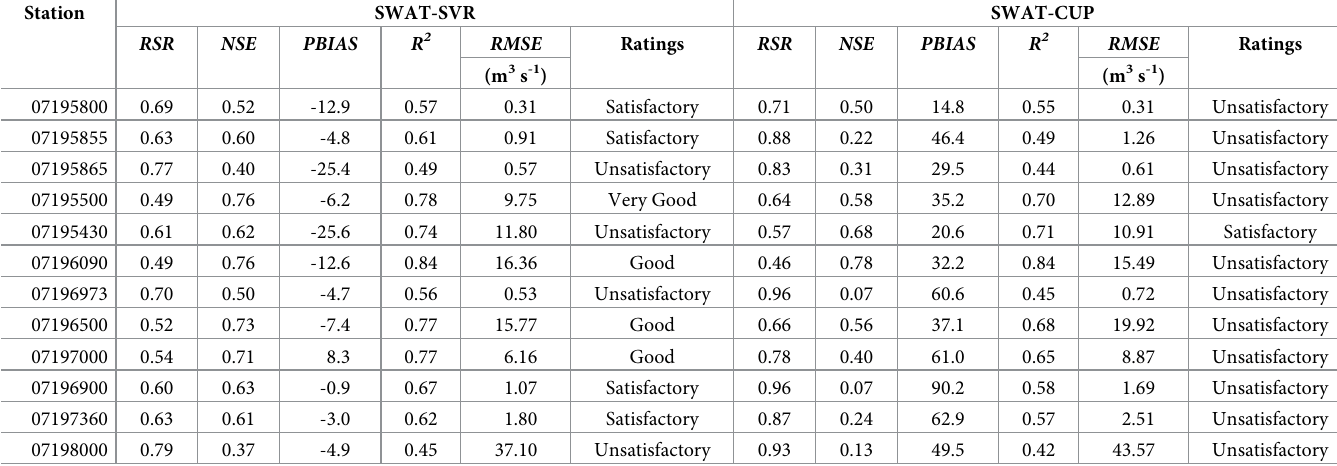
Table 5. Overall performance ratings by SWAT-SVR and SWAT-CUP after combining wet and dry